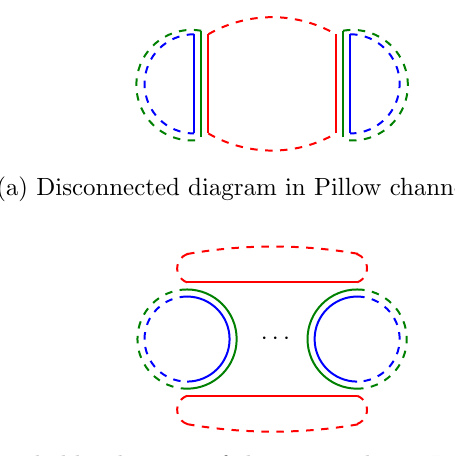
(b) Unbroken ladder diagram of the same color in Pillow channel (cid:24) N 4 . Figure 17. Leading and sub-leading diagrams in Pillow channel. The dashed line represents contraction of external gauge